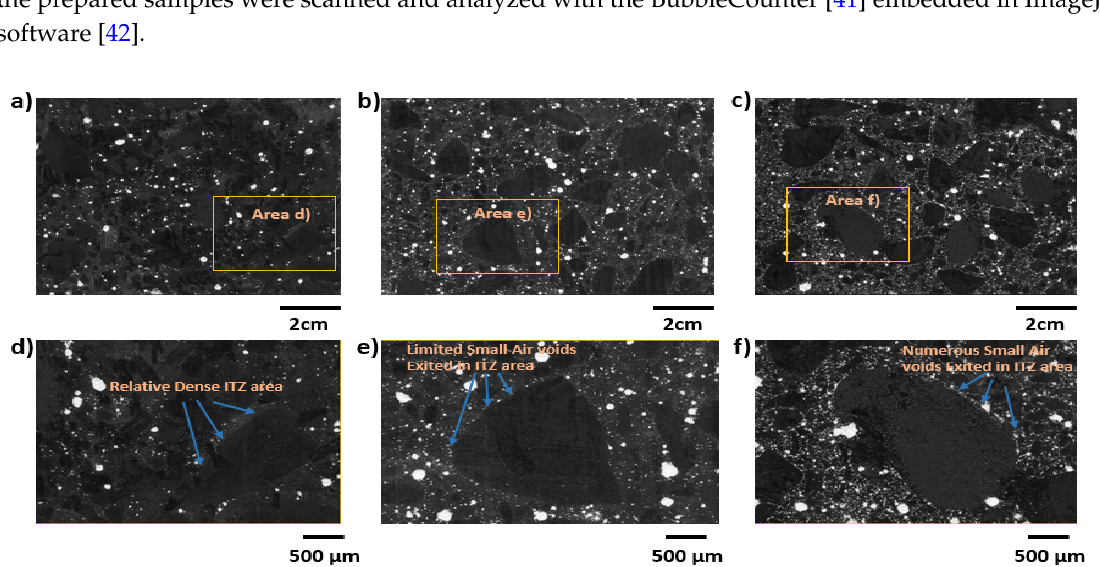
Figure 10. Scanned pattern of concrete slabs from the ASTM (American Society for Testing and Materials) C457 Test. ( a ) The scanned results of Sample Type 1; ( b ) The scanned results of Sample Type 2; ( c ) The scanned results of Sample Type 3d; ( d ) The demonstration of the Interfacial Transition Zone (ITZ) area (Area d)) in Sample Type 1; ( e ) The demonstration of the ITZ area (Area e)) in Sample Type 2; ( f ) The demonstration of the ITZ area (Area f)) in Sample Type 3.